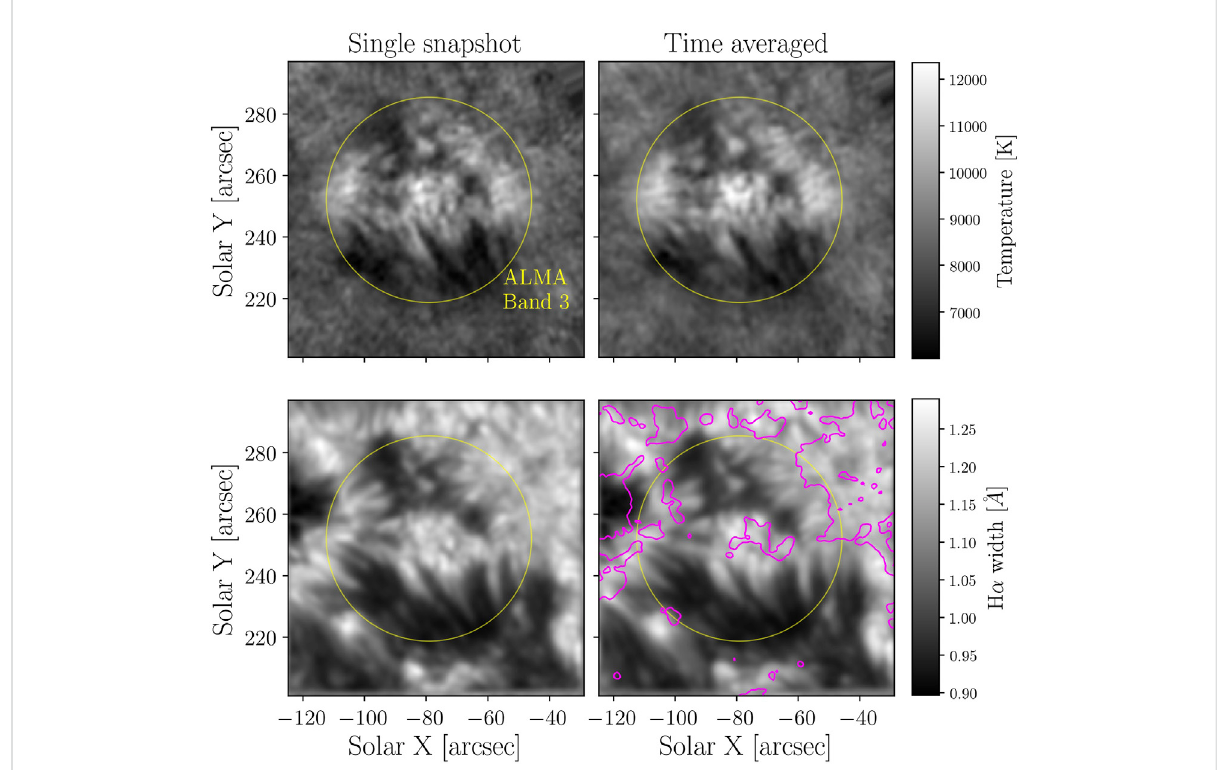
FIGURE 8 Maps of ALMA intensity (top row) and IBIS H α line width (bottom row), the latter smoothed to match the resolution of the ALMA data. The left columnshowsthetwoparametersatsingletimestepoftheobservations,whiletherightcolumnshowsthesametwoparametersaveragedoverthe 10 minutes ofacontinuous ALMA observation block.The yellowcircle hasadiameter of66 ″ ,slightly larger than theusableFOV ofALMA.The purple contours show areas withmagnetic fi eldstrength above 500Gauss,as measuredby HMI.FromMolnaret al. (2019). Reproducedbypermission of the